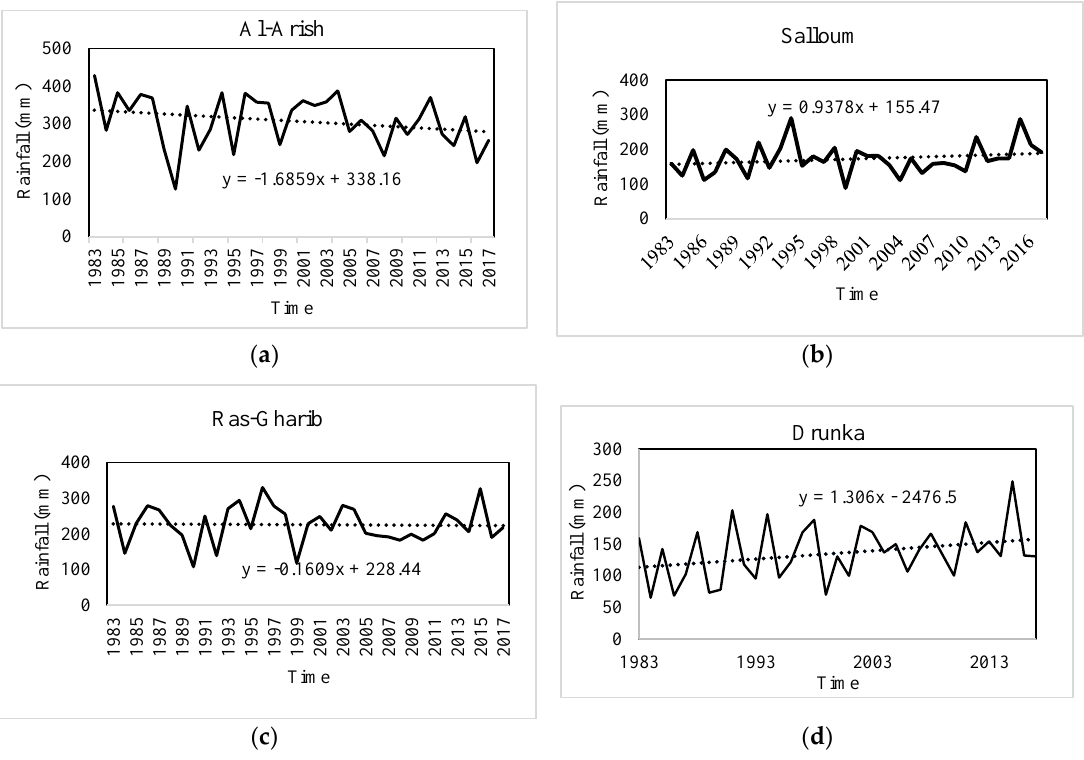
Figure 7. The trend analysis of the annual rainfall data from 1983 to 2018 using the PERSSIAN-CDR long-term rainfall data over the four selected regions ( a – d ).